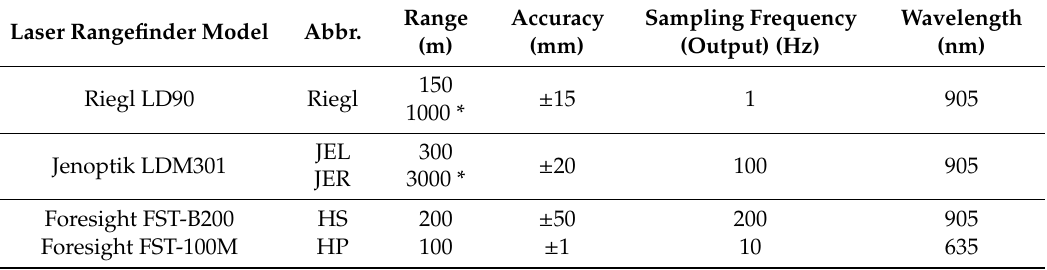
Table 5. LIDAR parameters.